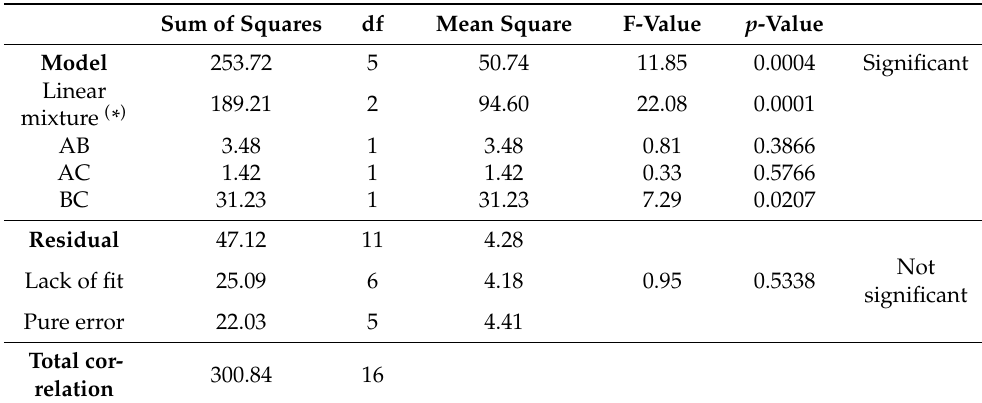
( * ) : Inference for linear mixtures uses type I sums of squares. A: BSO % w / w ; B: TCP % w / w ; C: HCO-30 % w / w